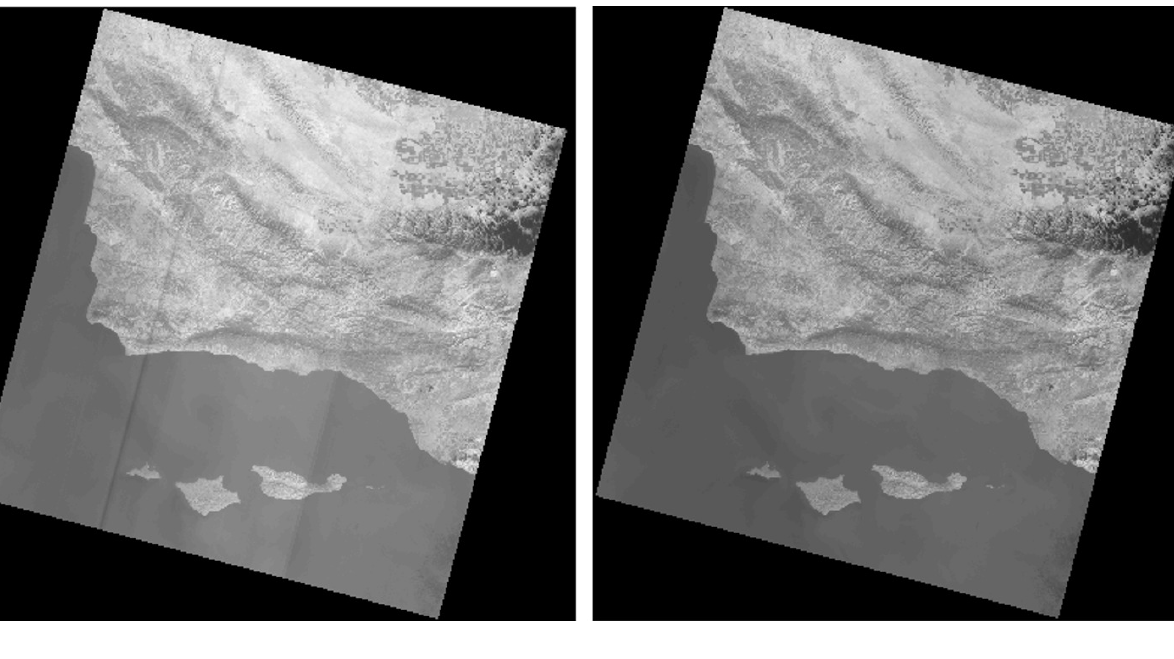
Figure 10. TIRS Band 11 scene of WRS2 Path/Row 042/036 (25 September 2013) calibrated with the pre-flight calibration parameters ( left ) and with the adjusted parameters based on the characterization data collections during the on-orbit checkout ( right ). The